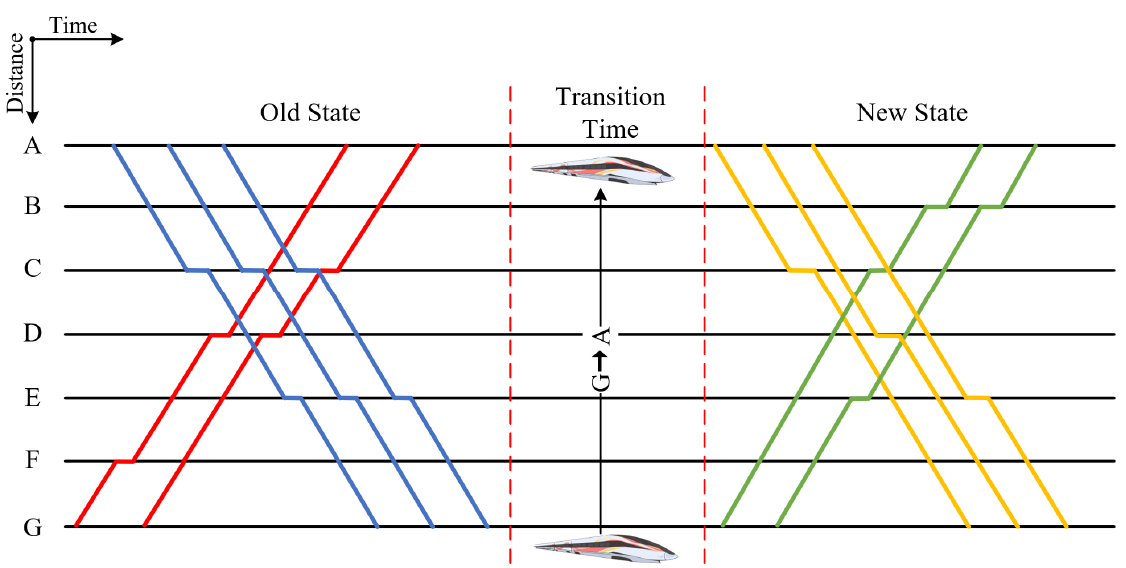
Figure 3. The schematic diagram of the timetable switching method.